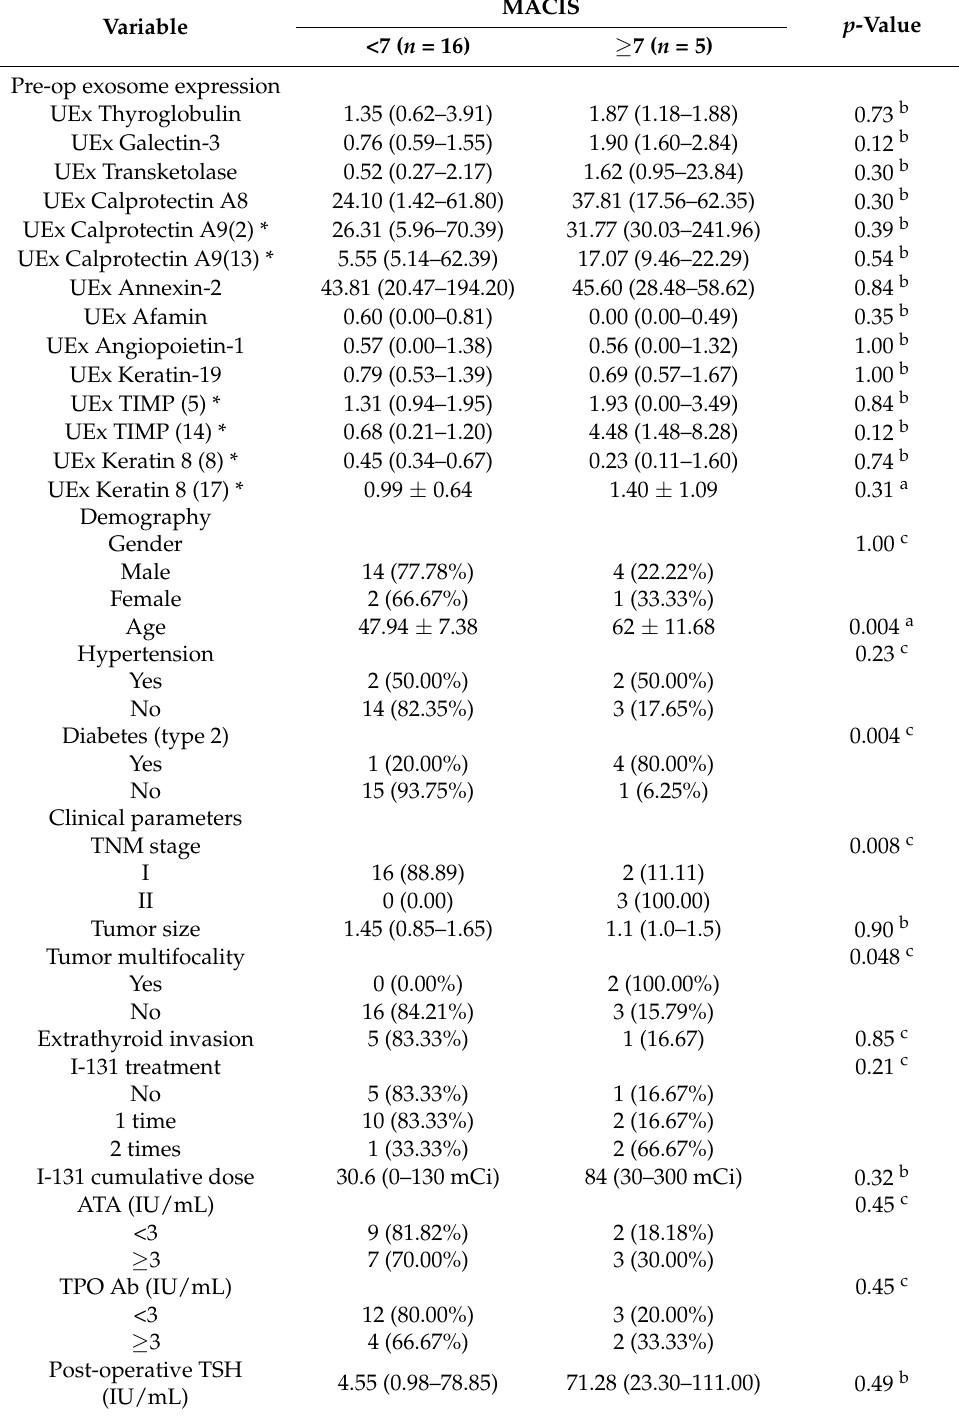
Table 4. The association between pre-operative expression of exosomal peptides and MACIS (metas- tasis, age, completeness of resection, invasion, and